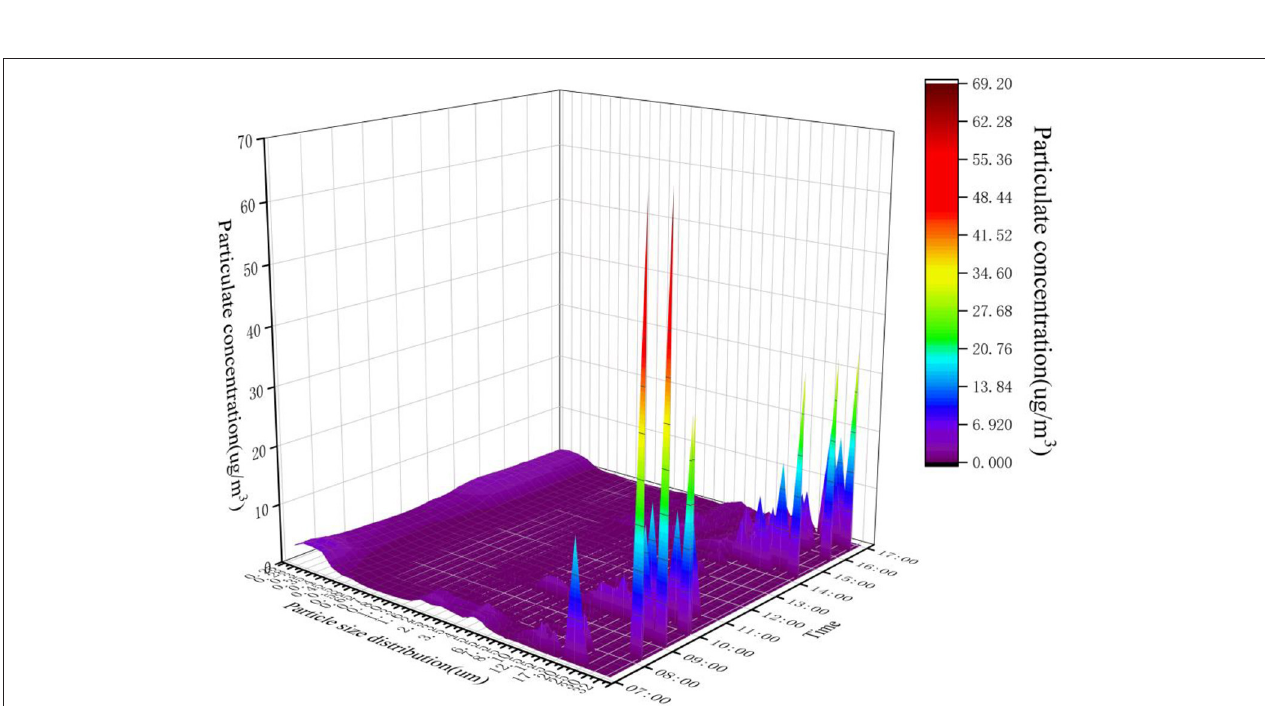
FIGURE 7 | Particle diameter distributions in the library: particle diameter-time-concentration.